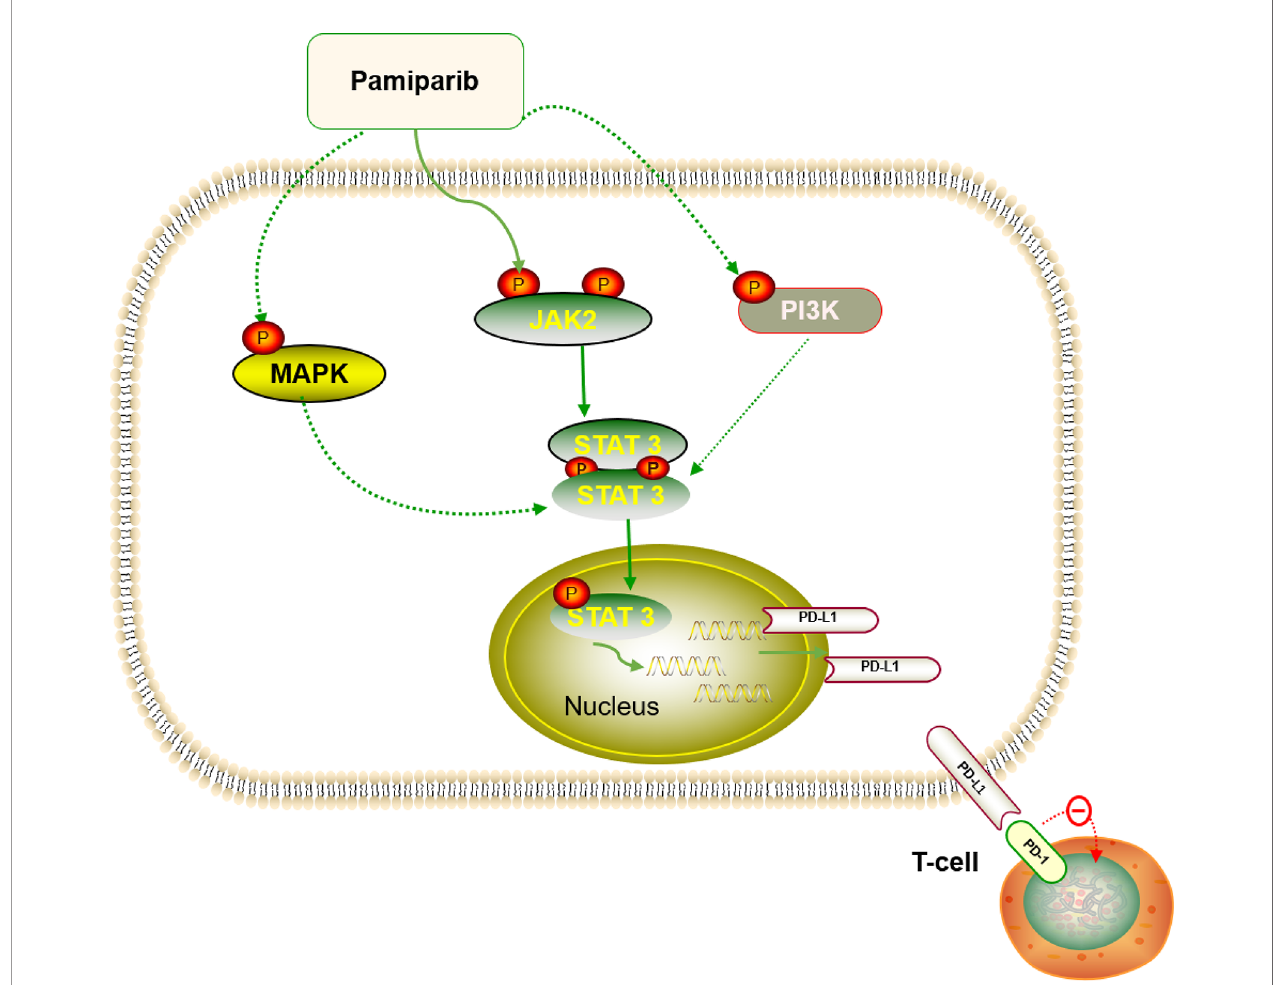
FIGURE 8 | Diagram summarizing that pamiparib treatment induces PD-L1 expression mainly via JAK2/STAT3 in pancreatic cancer (details provided in the Discussion